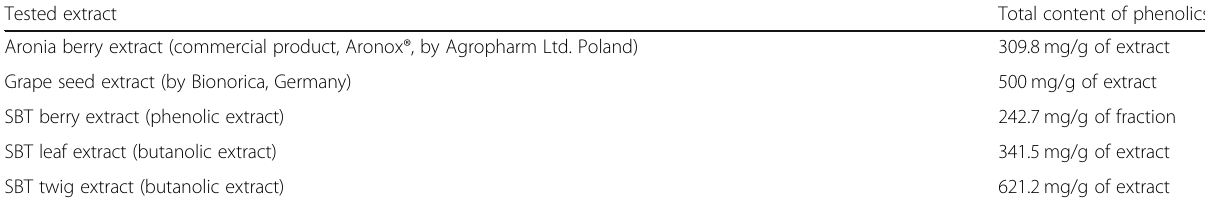
Table 1 Total content of phenolics in the extracts used in this experiment [3, 4, 11 – 14, 23] Tested extract